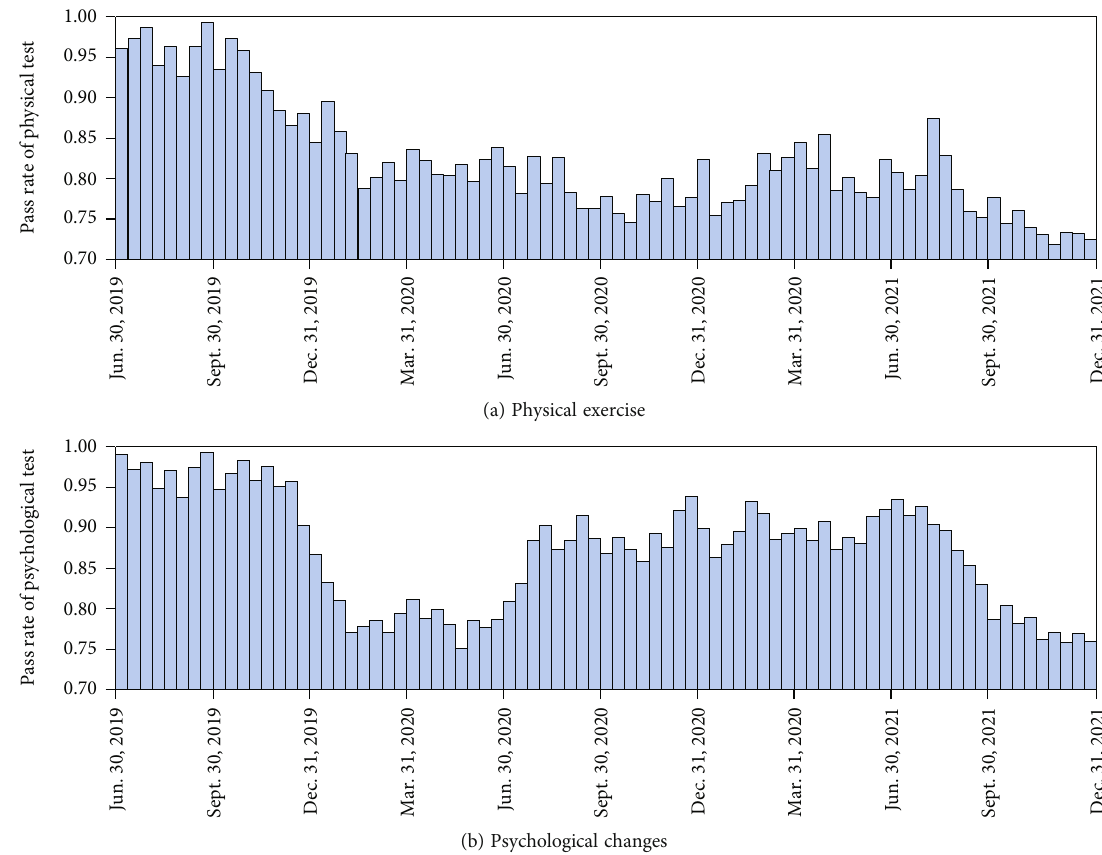
Figure 4: Physical exercise and psychological changes of college students before and after the intervention based on multidimensional data